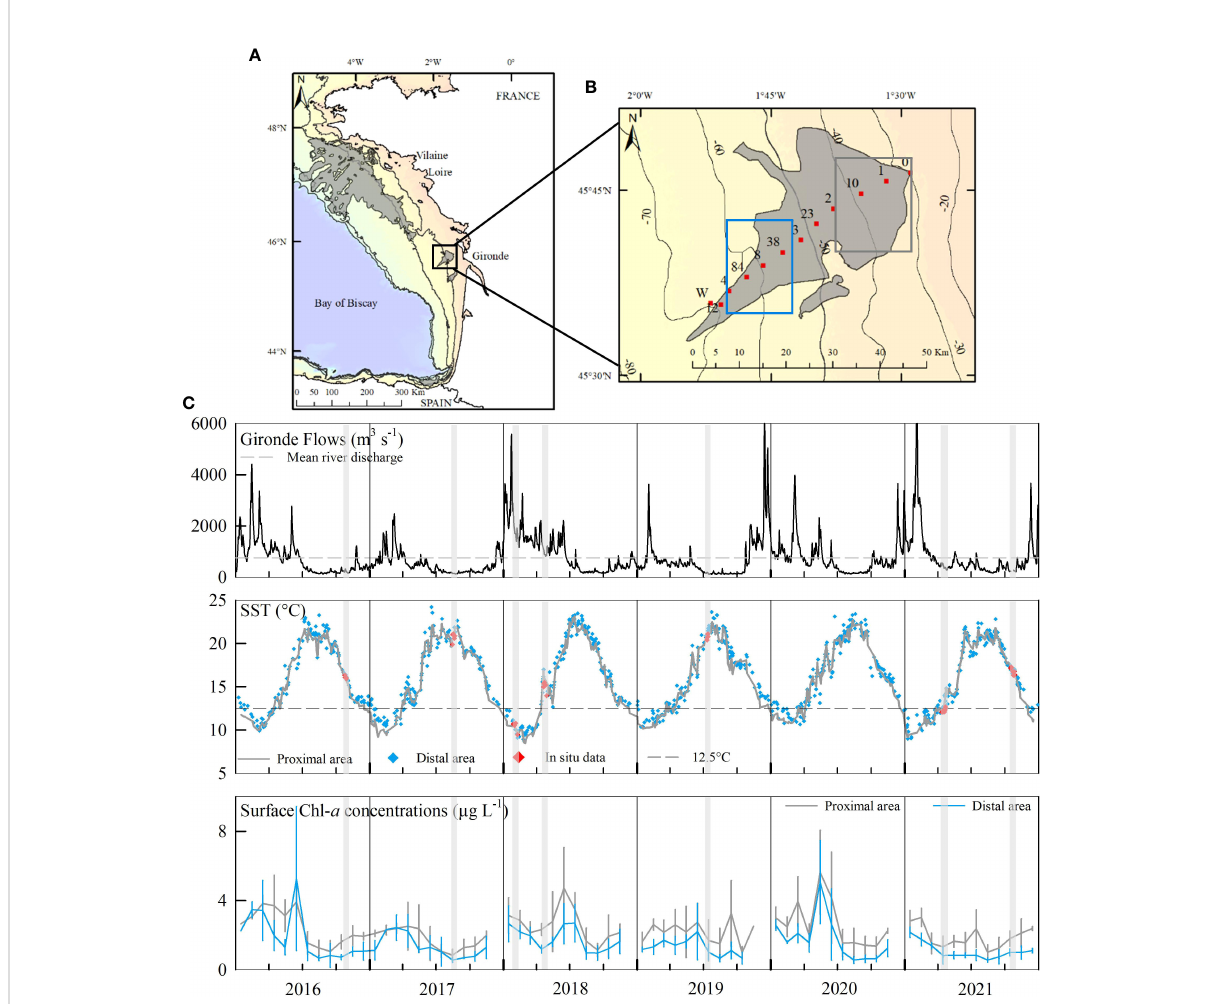
FIGURE 1 (A) The Bay of Biscay with the locations of mud patches (gray areas) and of the two main rivers, (B) map of the WGMP showing the locations of sampling stations (red squares) and the areas of satellite data extractions (rectangles). (C) Hydrological context: Gironde fl ows, Sea Surface Temperatures and monthly averages of surface Chl- a concentrations in the distal and proximal areas from the 01/01/2016 to the 12/31/2021. Gray lines indicate sampling